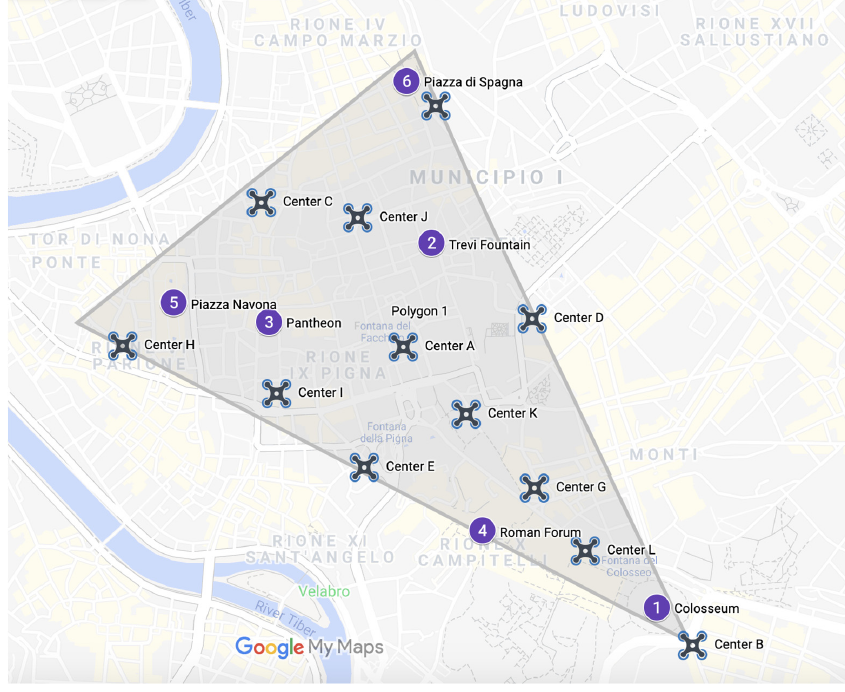
Figure 1. Hotspot Triangular Zone. Note: Numbers in blue circles represent selected touristic hotspots in Rome, Italy, including 1. Colosseum; 2. Trevi Fountain; 3. Roman Forum; 4. Pantheon; 5. Piazza di Spagna; 6. Navona. pinpoints the candidate drone locations, indicated by capital letters from A to L. Source: Google Maps, 2020.